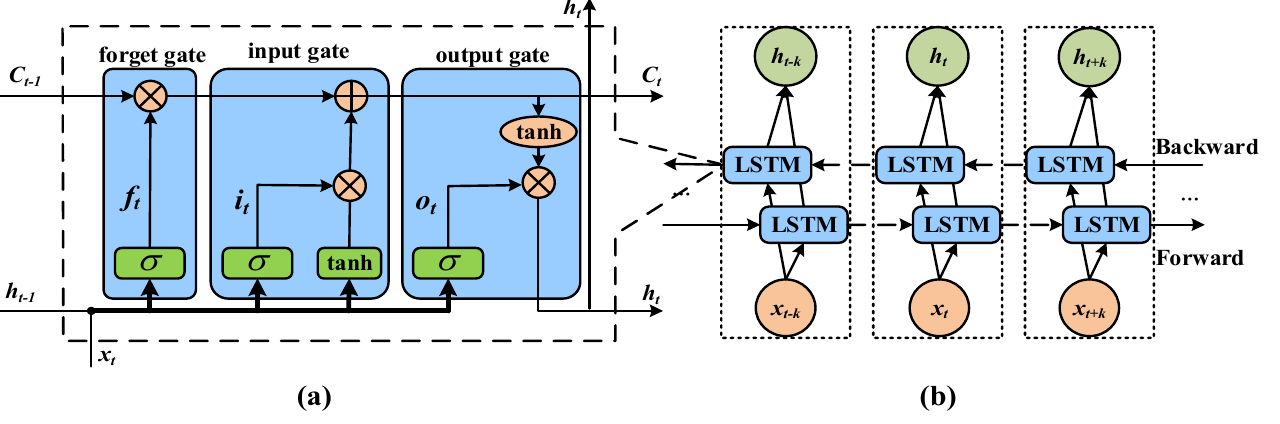
Figure 4. ( a ) Internal structure of LSTM unit; ( b ) Bidirectional LSTM network structure. The specific internal operation process of CNN-BiLSTM neural network structure can be expressed as: